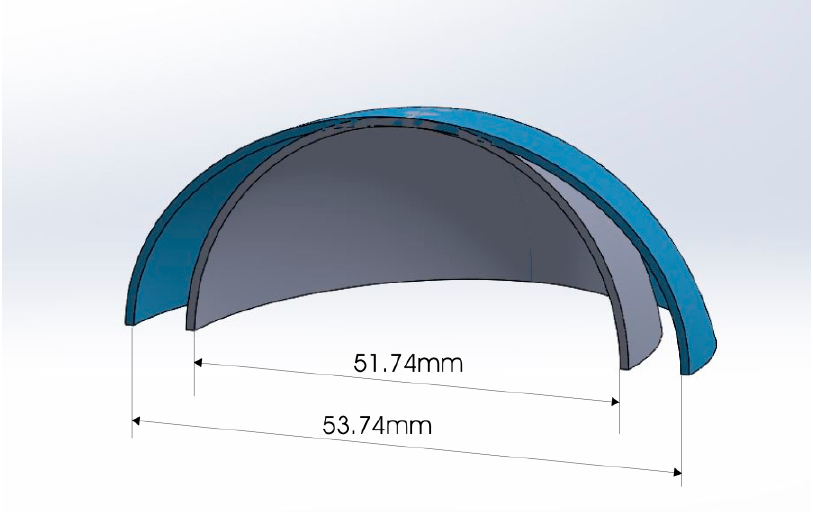
Figure 7. The low-beam headlamp with laterally expanding ellipsoidal reflector No. 1.